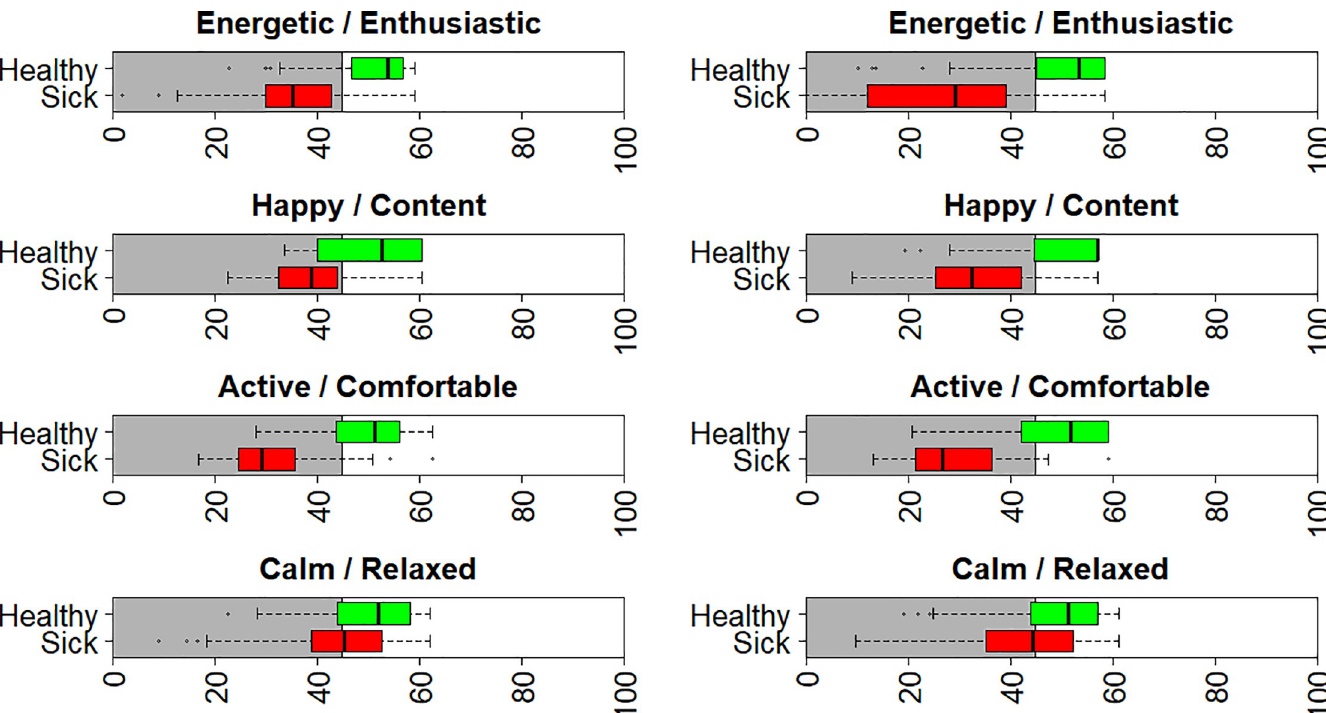
Fig 2. Boxplots of the normalised scores for young (left column) and old (right column) dogs. Boxplots are shown separately for healthy and sick dogs. The threshold is 44.8, with dogs above this point estimated to be healthy since 70% of healthy dogs lie above this threshold. The density plot explaining the choice of the threshold is given in Fig 1.